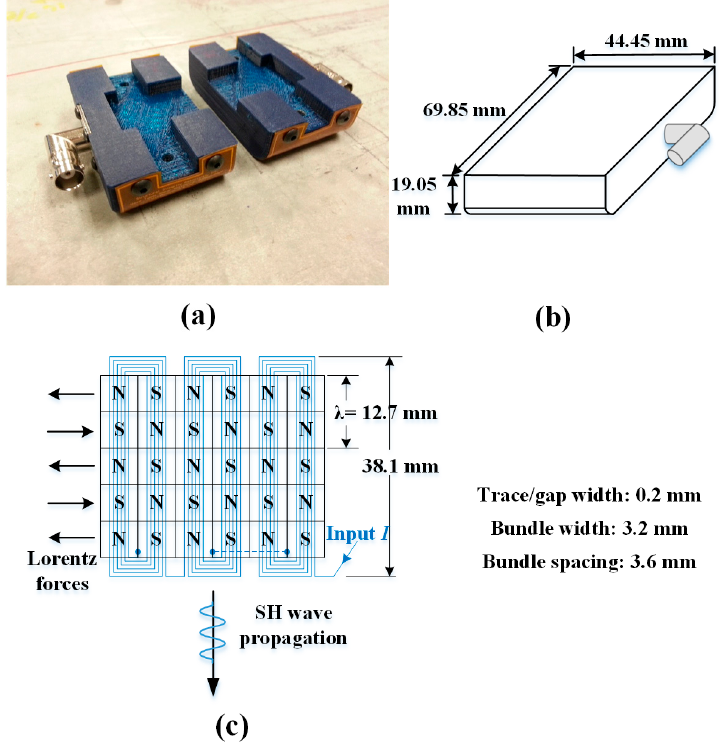
Figure 2. ( a ) Pair of PPM EMATs; ( b ) housing dimensions; and ( c ) layout of permanent magnets and electric coil.